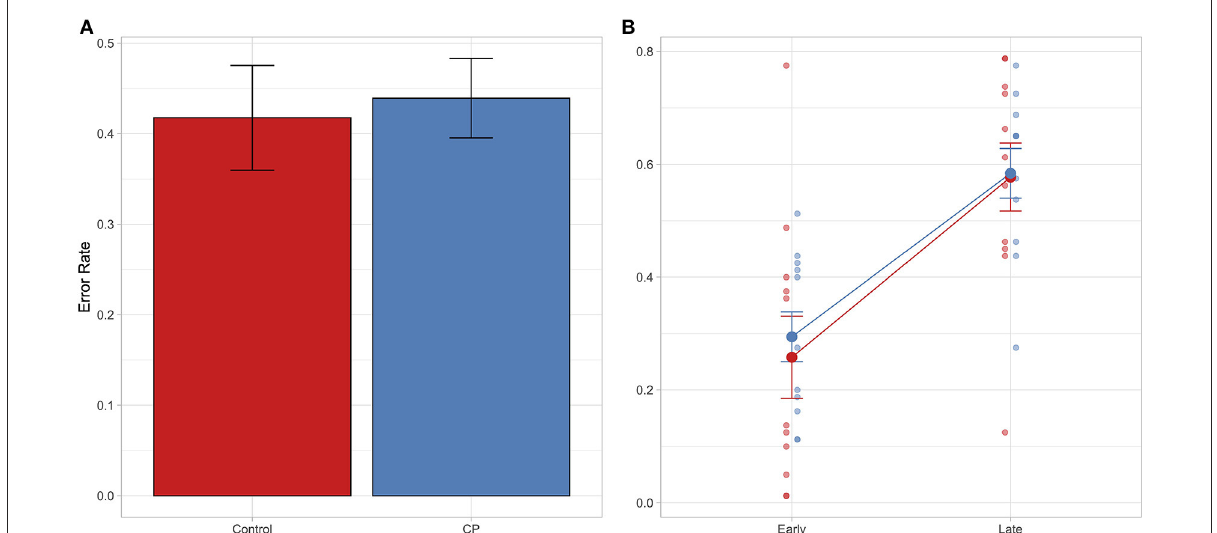
FIGURE2 In both panels it is reported the Error rate index calculated as follows: Incorrect response/(Correct response + Incorrect response). In (A) mean Error rate is reported as a function of group. In (B) mean Error rate is reported as a function of time-point and group. Error bar referred to the standard error of means. Individual data are also